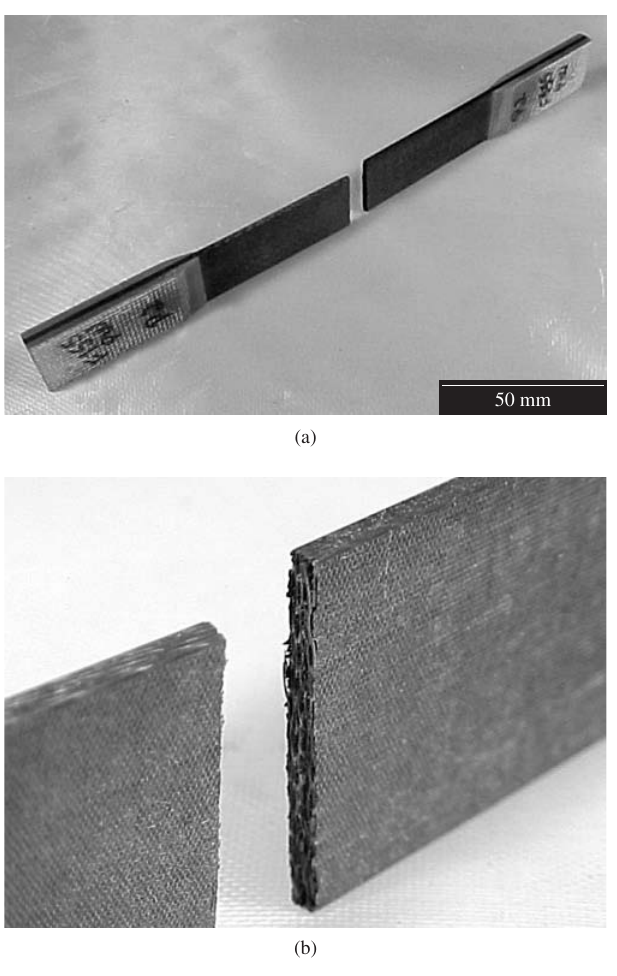
Figure 4. F155/PW laminate: a) specimen tested; and b) detail of the failure mode type LGM ( Lateral Gage Middle